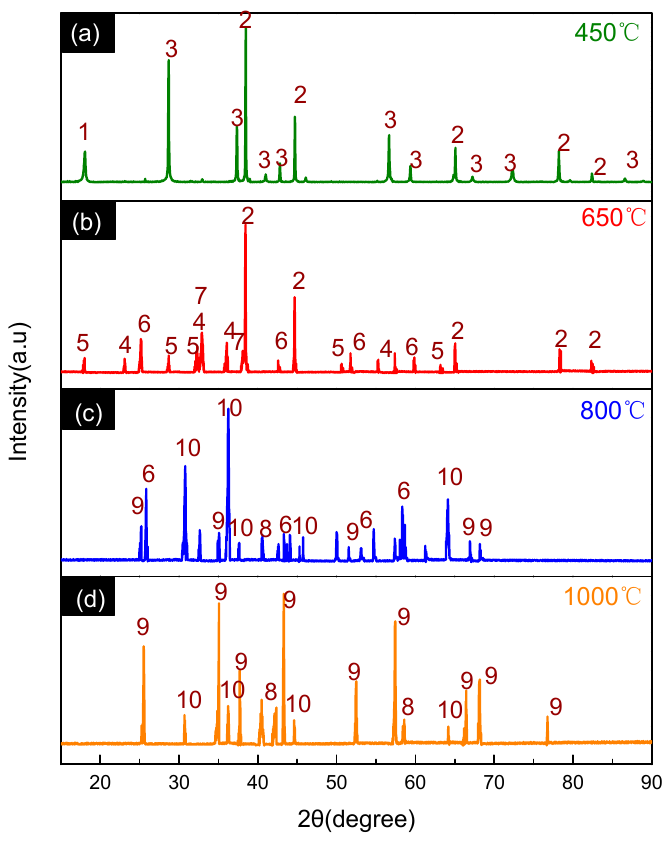
Figure 9. XRD patterns of PTFE/Al/MnO 2 solid residues at different temperatures. ( a ) XRD patterns at 450 °C; ( b ) XRD patterns at 650 °C; ( c ) XRD patterns at 800 °C; ( d ) XRD patterns at 1000 °C.